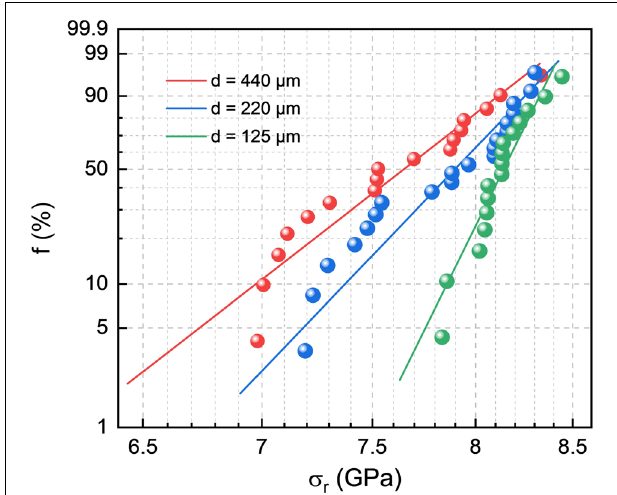
FIGURE 8 | Statistical analysis of the first pop-in for silica glass fibers with varying diameter d . The representative mean indentation stress σ r associated with the occurrence of the first pop-in was taken from Figure 7B and Supplementary Figures S1, S2 . Weibull probability data f were determined using median rank approximation (Moayedi and Wondraczek, 2017). Nanoindentation testing was performed using a wedge-shaped tip with an opening angle of 60 ◦ and an effective length of 180 µ